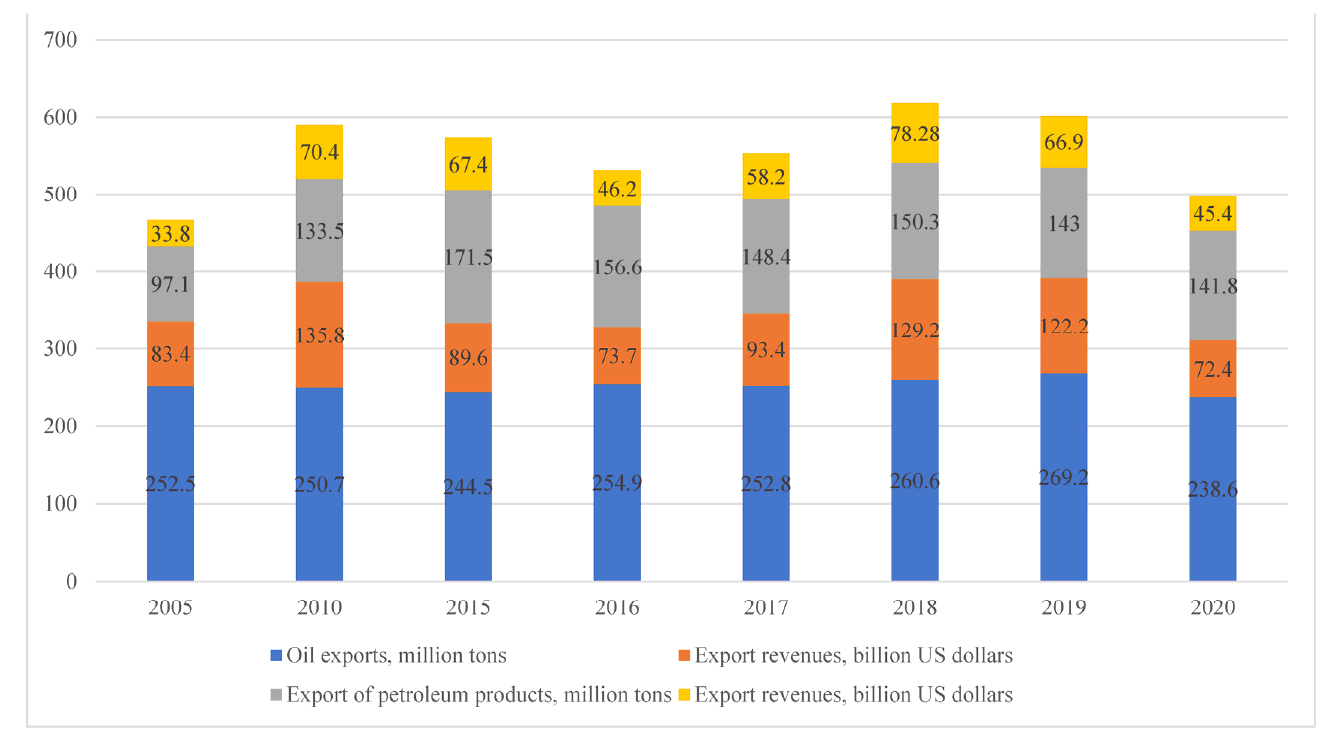
Figure 7. Dynamics of oil and petroleum products exports of the Russian Federation for 2005–2020.